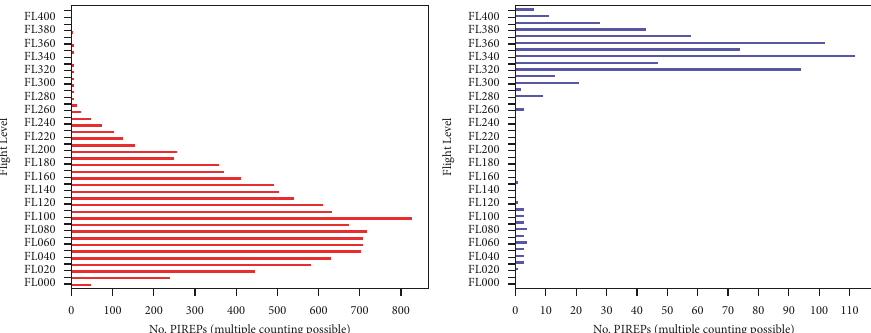
Figure 2: Distribution of the PIREPs by altitude (left: positive icing, right: negative icing). Note that different ranges on the abscissa are shown due to the relatively small number of no icing reports. One report may be counted multiple times because the report identifies multiple